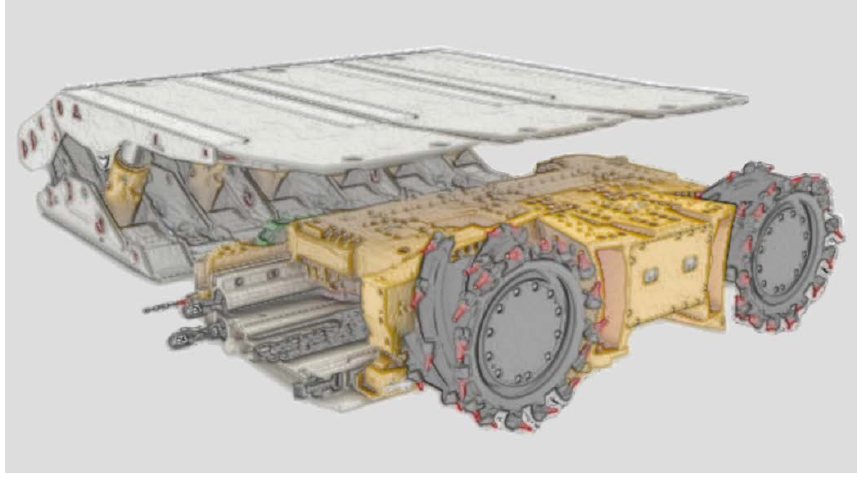
Figure 1. “Mikrus” longwall system [30].